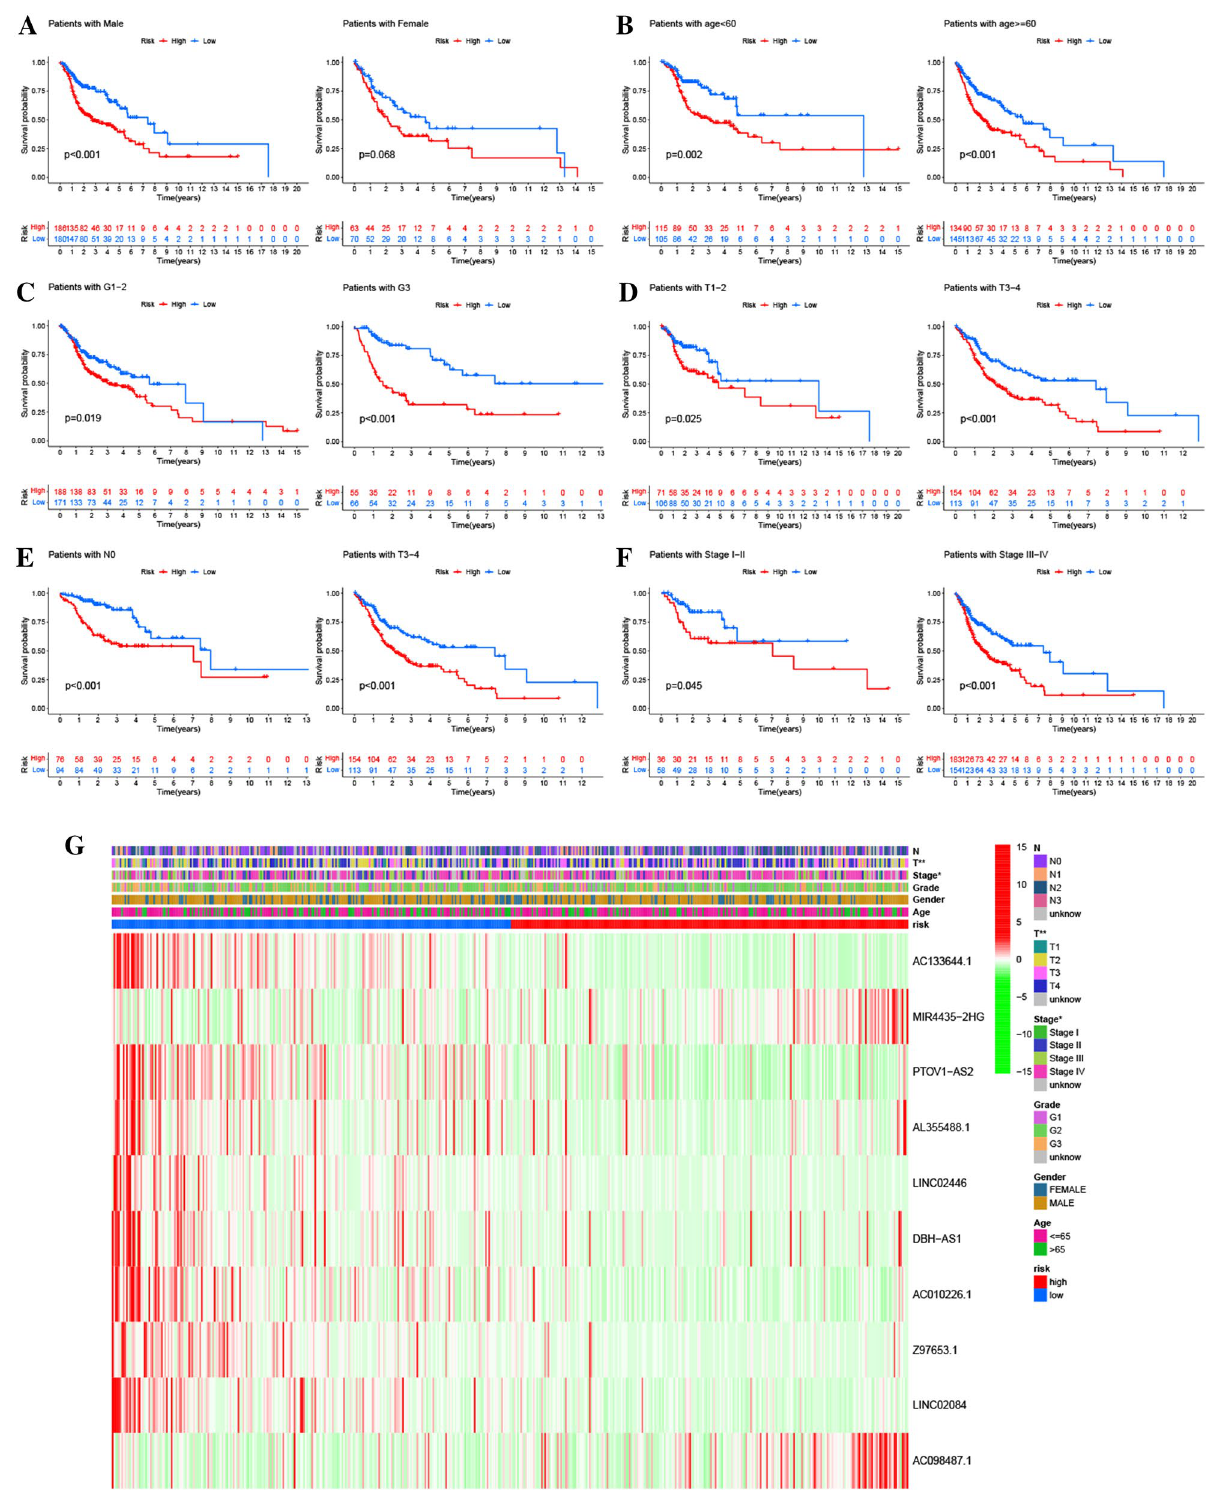
Figure 4. Survival curves of different risk scores in subcohorts. ( A ) Gender, ( B ) Age, ( C ) Histologic grade, ( D ) T stage, ( E ) Lymphatic metastasis, ( F ) Clinical stage; the correlation analysis revealed that stage III/IV and T3/4 patients exhibited an elevated risk score in contrast with the stage I/II and T1/2 patients ( G